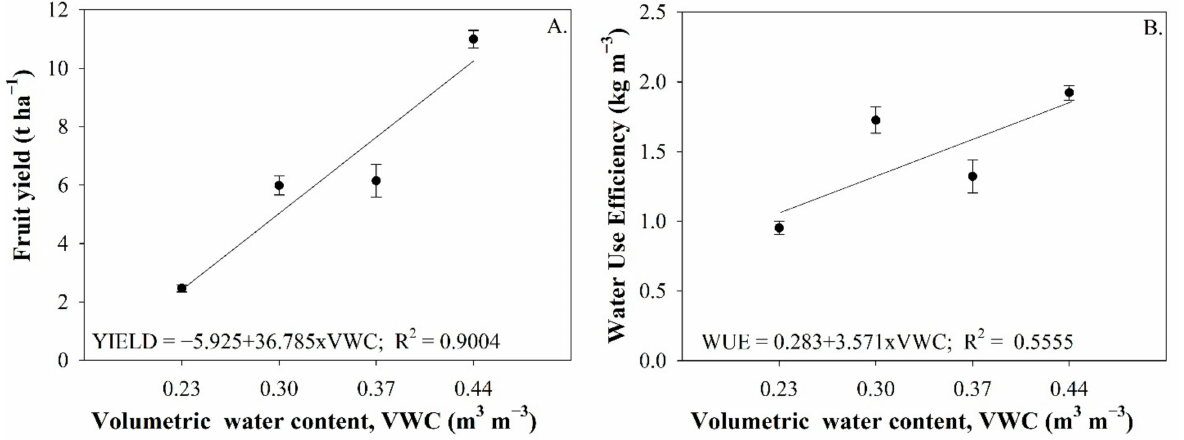
Figure 5. Fruit yield ( A ) and water use efficiency (WUE) ( B ) of two cherry tomato cultivars in response to increasing volumetric water contents. Each data point is the average of four replications ( n = 4). The equations were fit using all